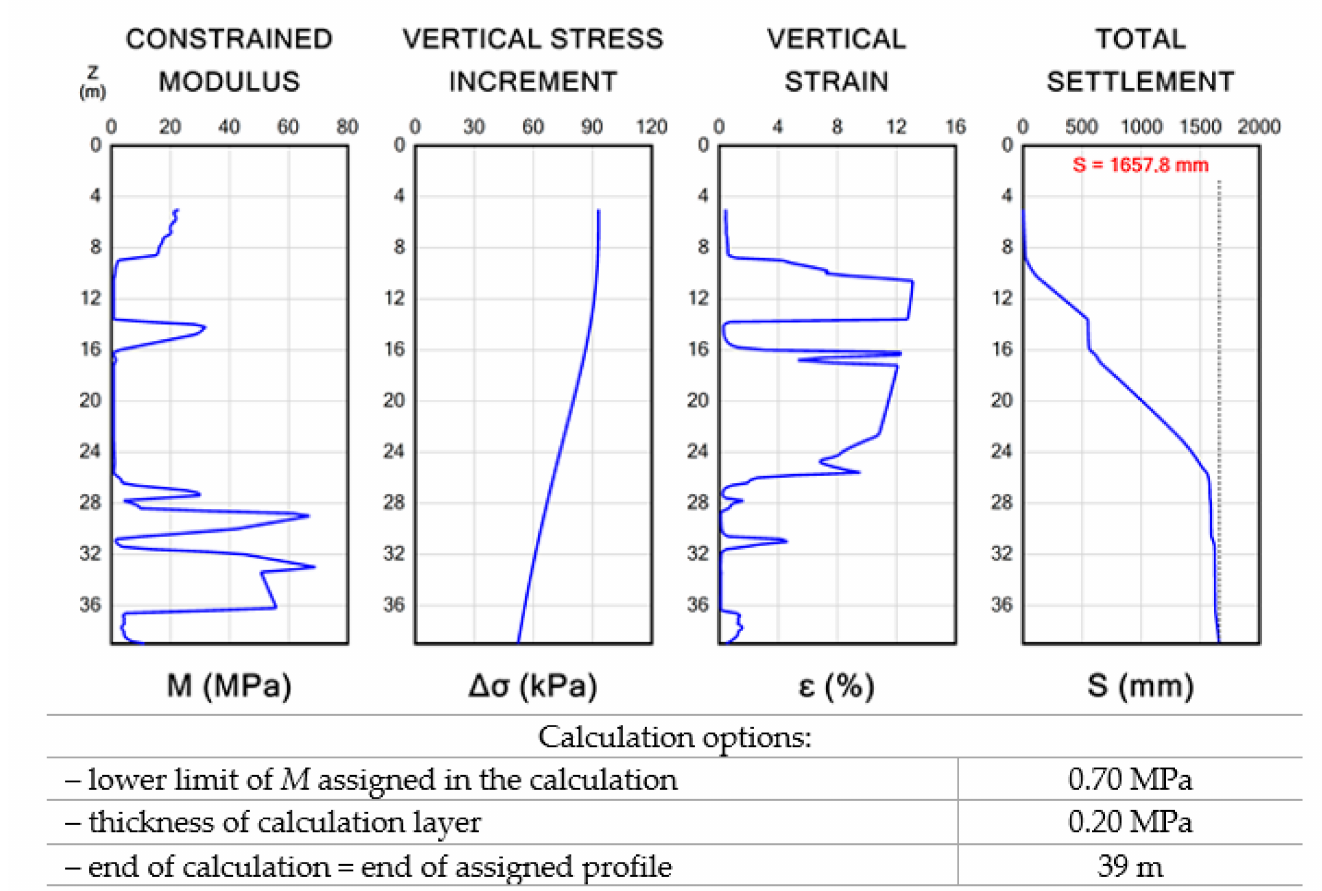
Figure 6. Results sheet of settlements calculation, below the centre (test point